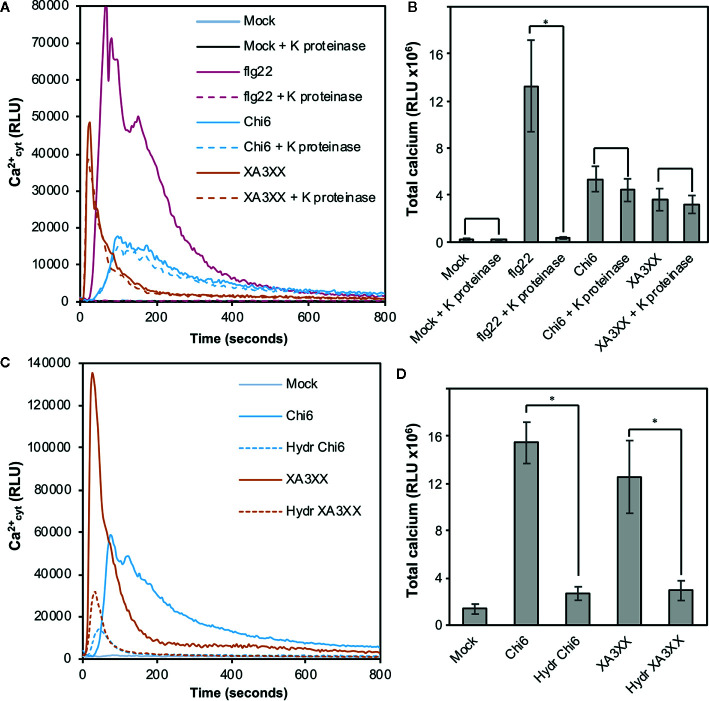
Proteolysis and acid hydrolysis effects on XA3XX calcium signaling. Variation of intracellular Ca2+ concentration after 800 s of treatment of Col-0AEQ seedlings with untreated flg22 (1 μM), chitohexaose (Chi6; 100 μM), or XA3XX (250 μM) (A, B) with or without proteinase K previous digestion and (C, D) with or without acid hydrolysis previous digestion. Data represent mean ± SD (n=8) from one experiment representative of two independent ones with similar results. Statistically significant differences according to Student’s t-test (*p < 0.05).